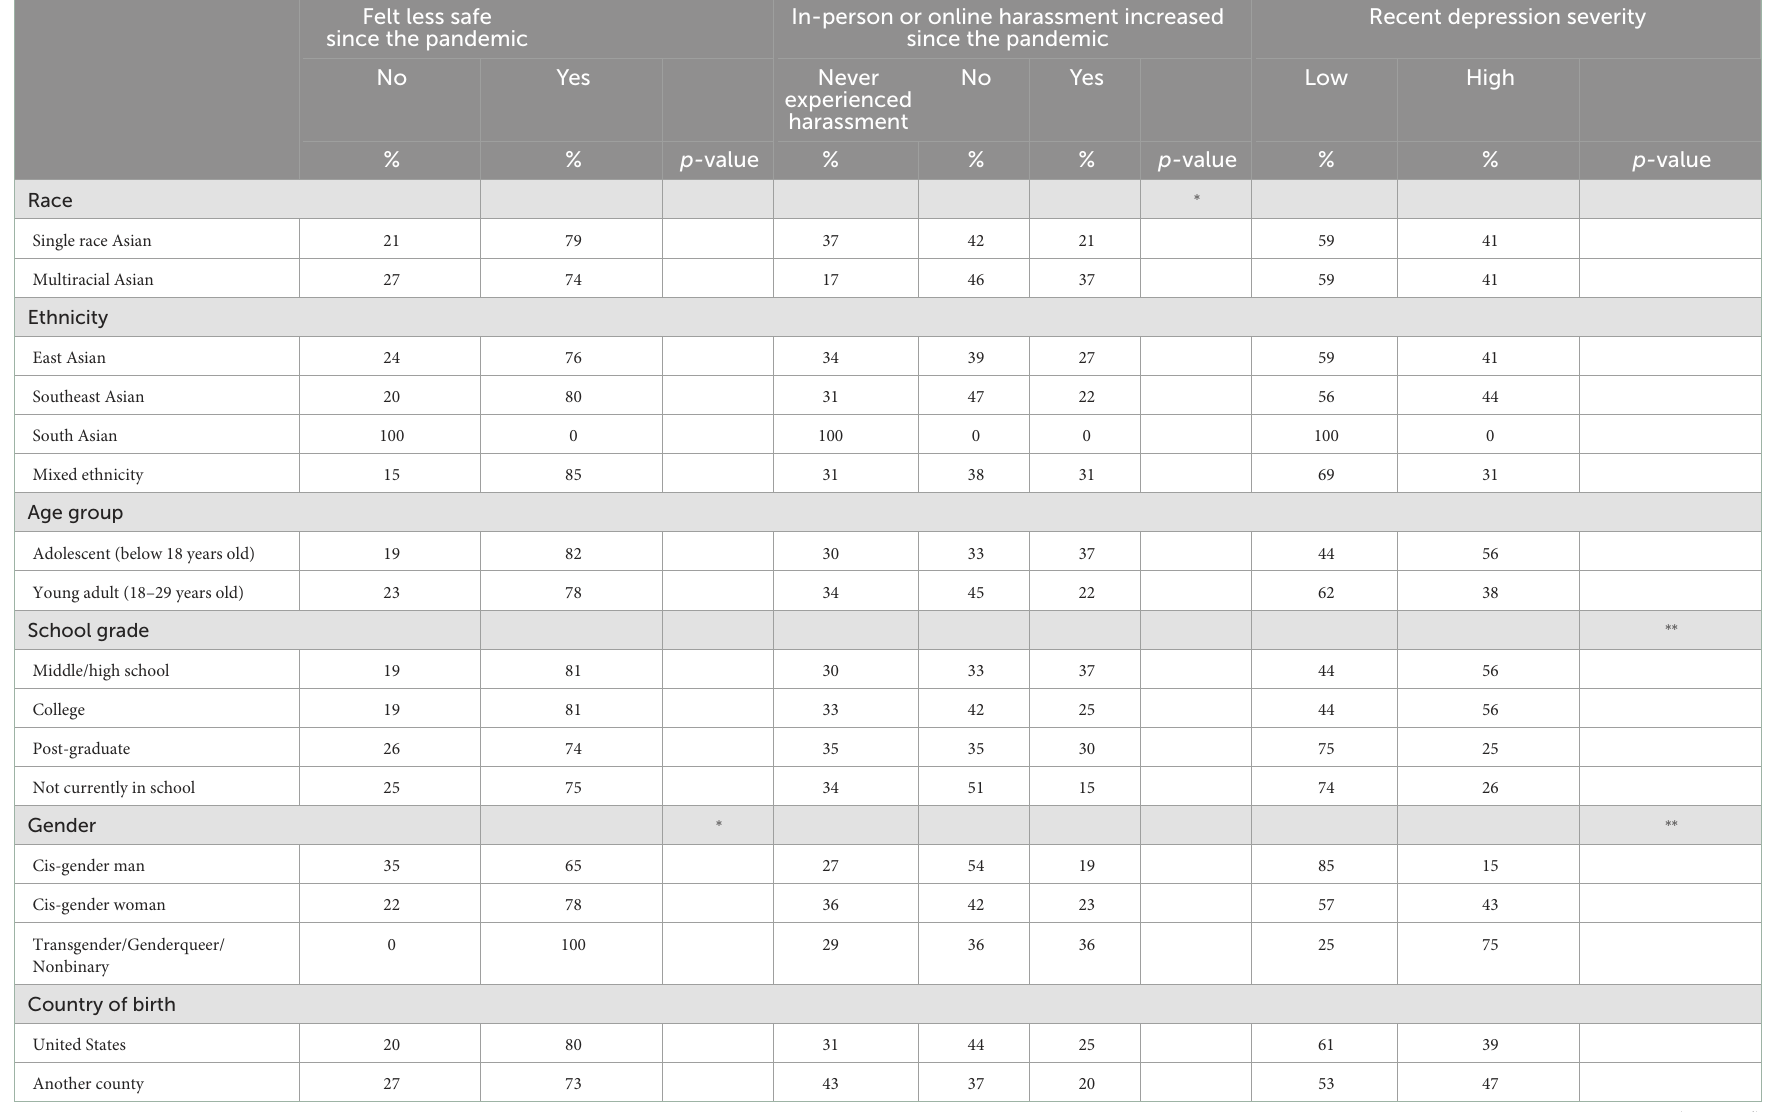
Recent depression severity